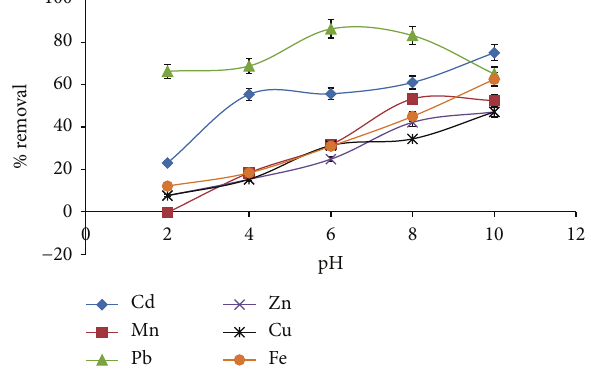
Figure 7: Effect of adjusting pH on metal removal by Moringa seed pods (MSP). Other conditions kept